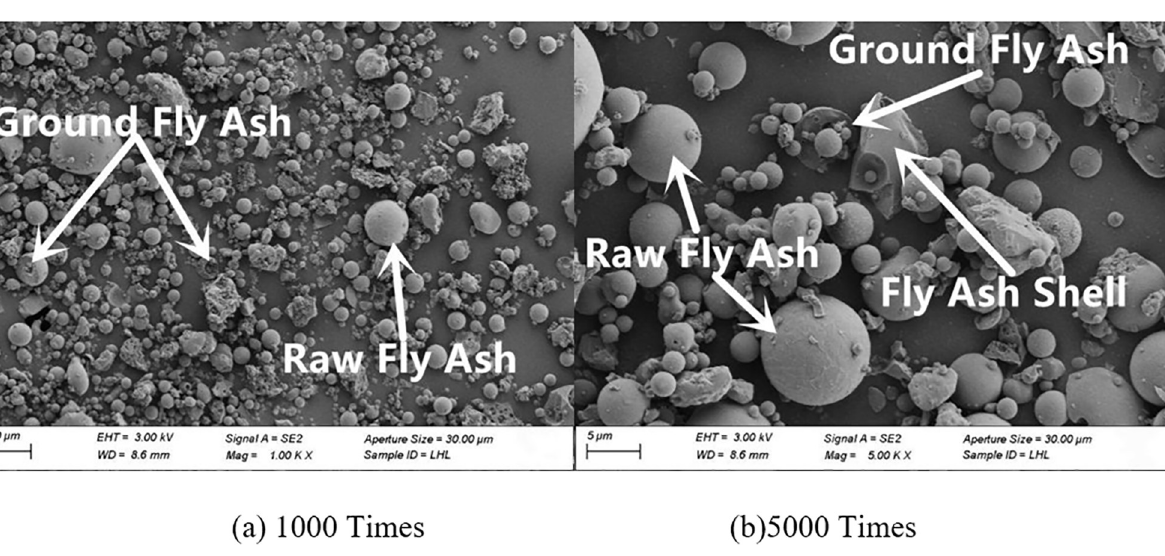
Fig 8. Fly ash microstructure in grinding for 20